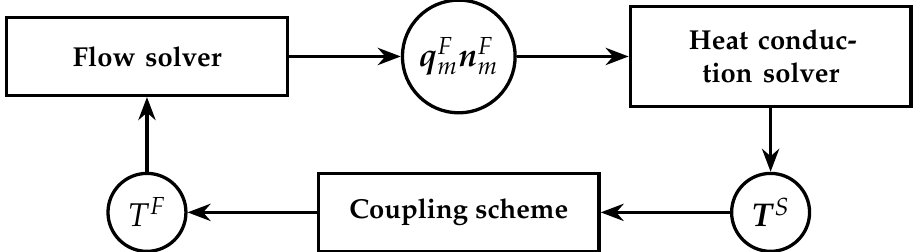
Figure 1. Schematic representation of the coupling of the flow and heat conduction solvers. A similar coupling applies to the adjoint